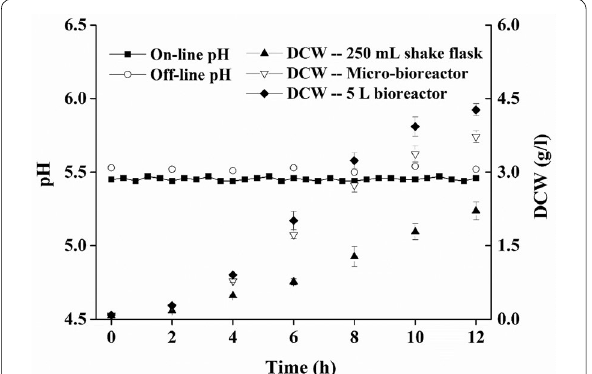
Fig. 5 A comparison of the cell growth of P. pastoris cultures in a 250- ml shake flask, micro-bioreactor, and 5-l